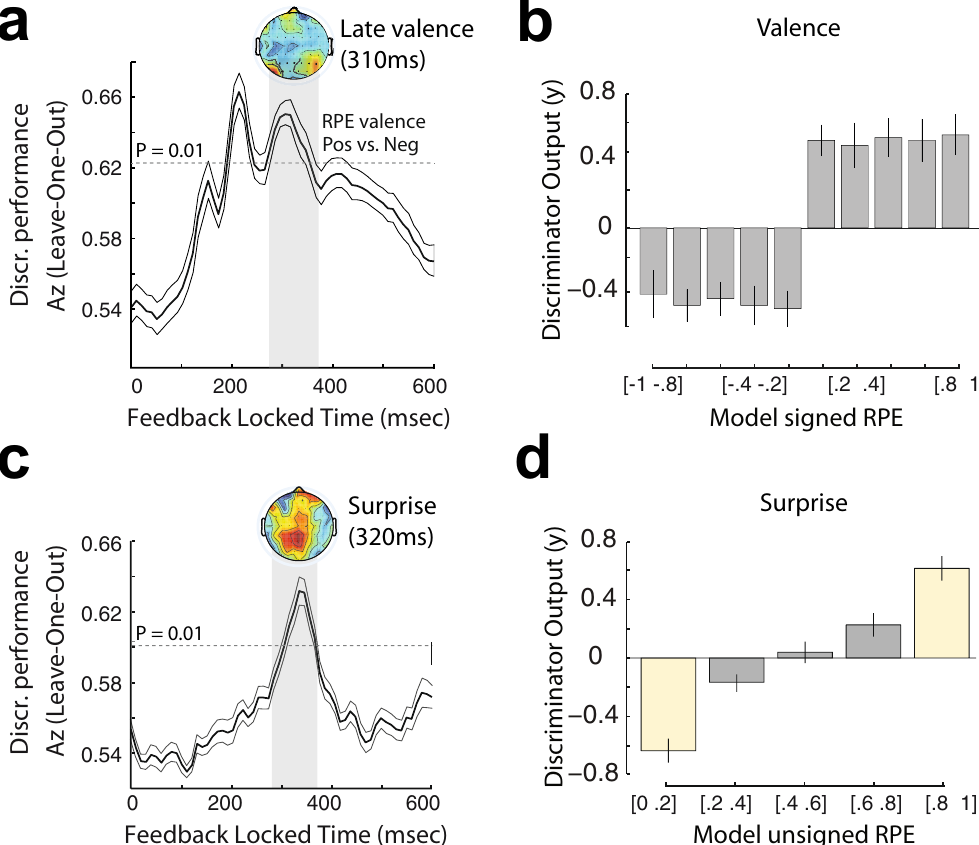
Figure 3. Single-trial EEG analyses. ( a ) Discriminator performance (cross-validated A z ) during RPE valence discrimination (positive vs. negative feedback) of outcome-locked EEG responses, averaged across subjects ( N = 20). The dotted line represents the average A z value leading to a significance level of P = 0.01, estimated using a bootstrap test. Shaded error bars are standard errors across subjects. In this work, we are focusing only on the second of the two RPE valence components (Late Valence component). The scalp map represents the spatial topography of this component. ( b ) Mean discriminator output ( y ) for the Late valence component, binned in ten quantiles based on model-based signed RPE estimates. This component exhibits mainly a categorical response profile without an additional modulation by the magnitude of the RPE. ( c ) Discriminator performance (cross-validated A z ) during RPE surprise discrimination (very low vs. very high surprising outcomes), averaged across subjects ( N = 20). The dotted line represents the average A z value leading to a significance level of P = 0.01, estimated using a bootstrap test. Shaded error bars are standard errors across subjects. The scalp map represents the spatial topography of the outcome surprise component. (d) Mean discriminator output ( y ) for the outcome surprise component, binned in five quantiles based on model-based unsigned RPE estimates, showing a parametric response along the outcome surprise dimension. Yellow bins indicate trials used to train the classifier, while grey bins contain “unseen” data with intermediate outcome surprise levels. Error bars are standard errors across